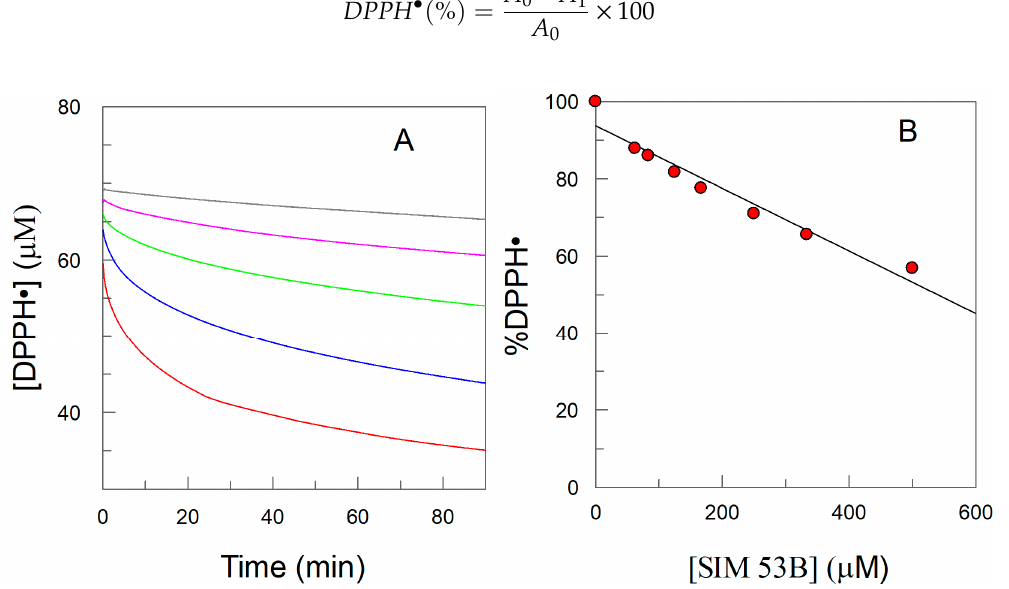
Figure 4. ( A ) Time course for the variation in the DPPH • concentration ([DPPH • ] initial = 70 μ M) in the presence of different concentrations of SIM-53B ( --- 35 μ M , --- 70 μ M, --- 140 μ M, --- 350 μ M, --- 700 μ M) at T = 20 °C. ( B ) Changes in the percentage of the initial DPPH • radical remaining (%DPPH • ) after the reaction with seven different concentrations of SIM-53B (62.5–500 μ M of SIM-53B) at time 180 min and T = 20 °C.